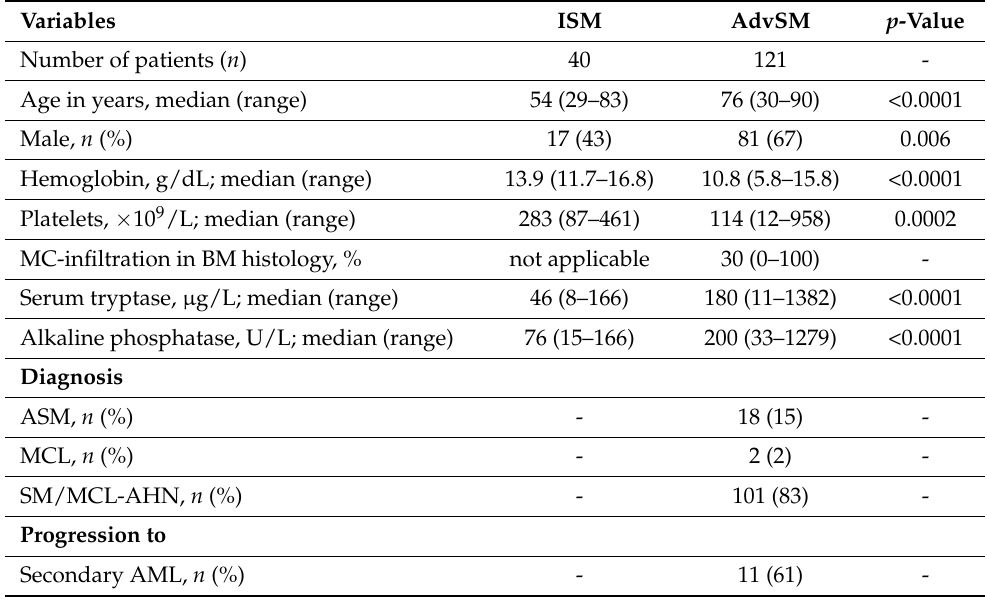
Table 1. Clinical, laboratory, outcome and treatment characteristics of patients with indolent systemic mastocytosis (ISM) and advanced SM